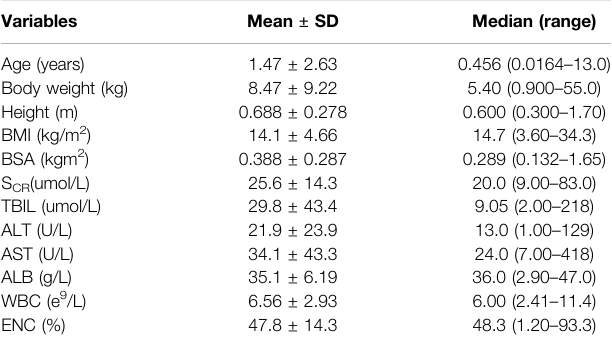
TABLE 1 | Demographic and baseline characteristics of the pediatric patients included in the population PK analysis ( n (cid:1) 108). Variables Mean ± SD Median